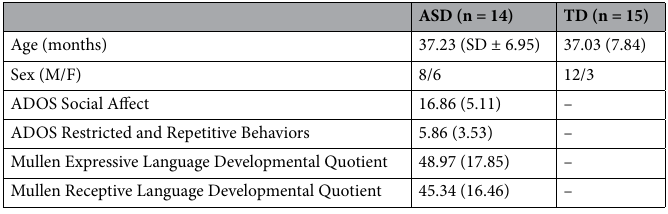
Table 1. Participant